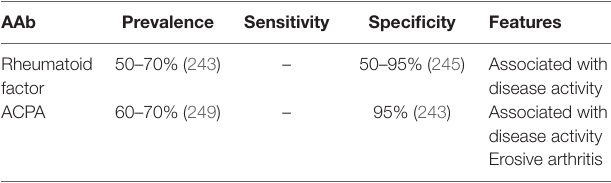
TAble 6 | AAb associated with rheumatoid arthritis.